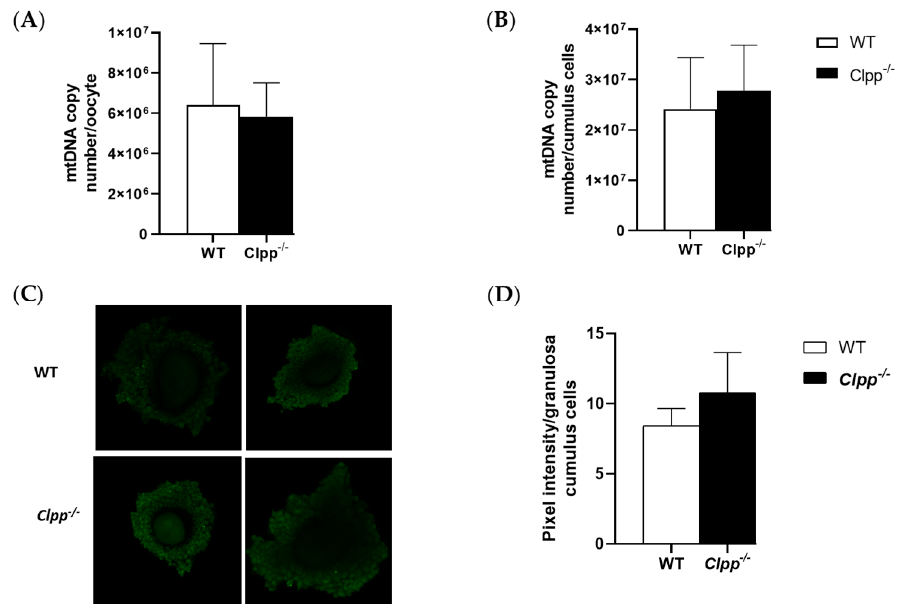
Figure 4. Mitochondrial function in Clpp − / − oocytes and cumulus cells. ( A ) mtDNA copy number was determined by qPCR in GV stage oocytes collected from 2-month-old Clpp − / − and WT mice. In each experiment, five mice were included in each group, and five GV oocytes/mice (a total of 25 GV oocytes per experiment) were analyzed. Each experiment was repeated three times. ( B ) mtDNA copy number was determined by qPCR in granulosa/cumulus cells collected from 2-month-old Clpp − / − and WT mice. In each experiment, five mice were included in each group, and granulosa/cumulus cells obtained from five COCs/mice (a total of 25 COCs per experiment) were analyzed. Each experiment was repeated three times. ( C ) Fluorescence intensity of carboxy-H2DCFDA was used to measure ROS levels in cumulus-oophorus complexes after treatment with H 2 O 2 . ( D ) Pixel intensity in granulosa cumulus cells is reported using Image J. Data presented as mean ± SEM.